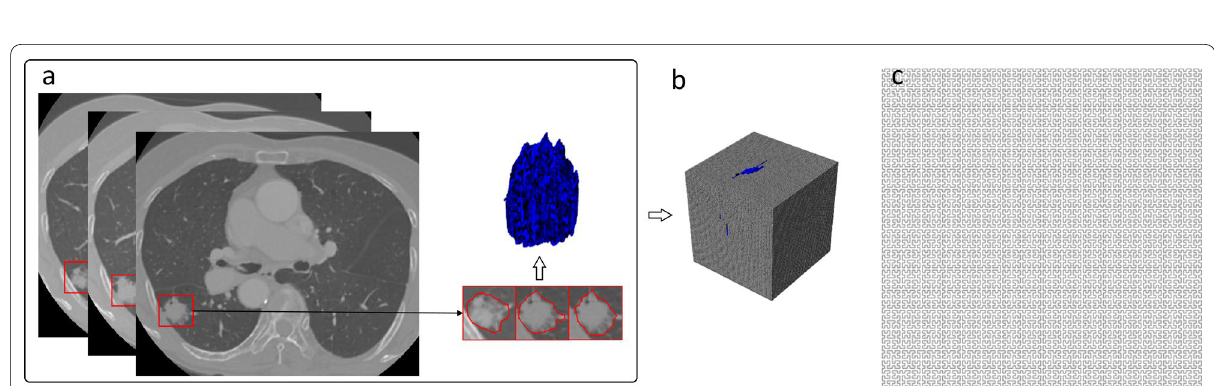
Fig. 4 a The lung tumor used to illustrate the three-dimensional (3D) Hilbert curve expansion. b The Hilbert volume with level 6 defined in this study, and the lung tumor (in blue) encapsulated in the Hilbert volume according to the 3D coordinates. c The empty Hilbert matrix to store the result of dimensionality reduction from ( b